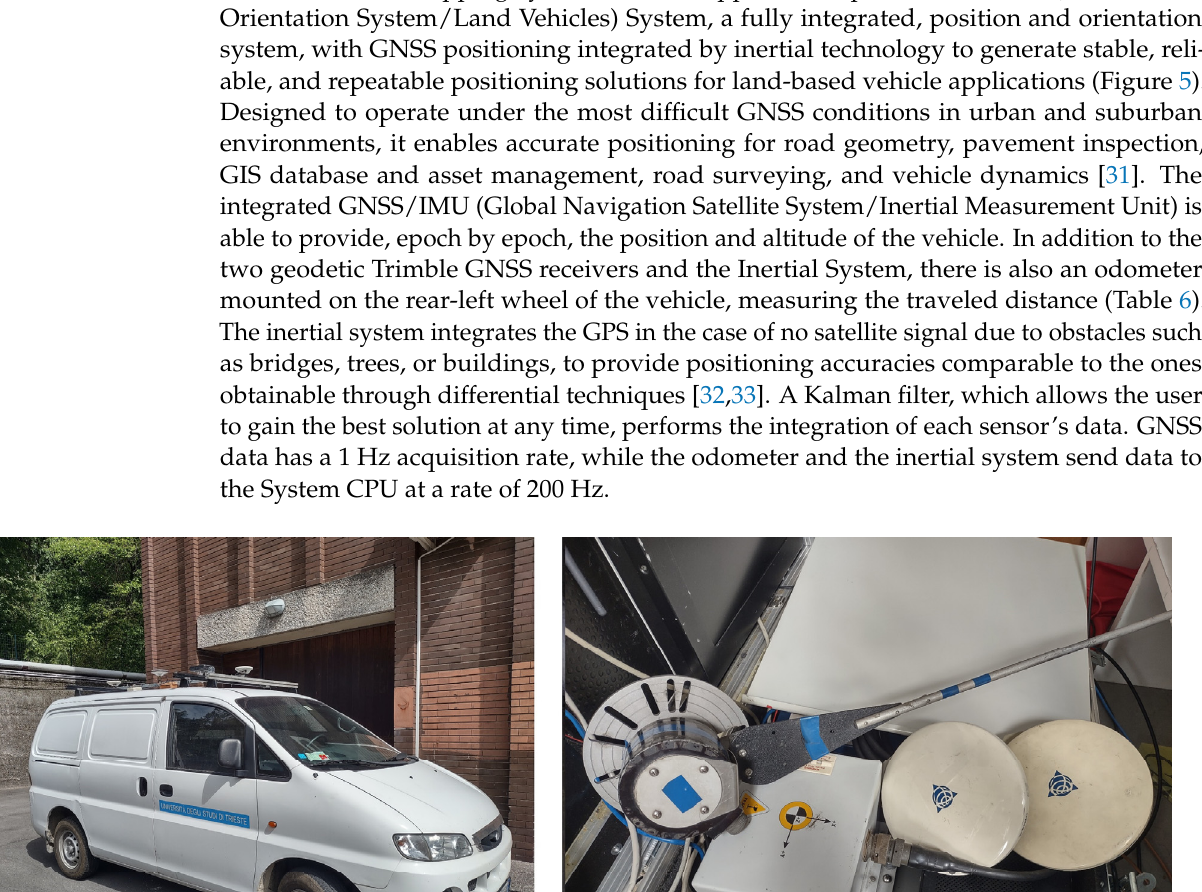
Figure 4. The surveyed area for terrestrial data collection. ( a ) in green, the reference trajectory